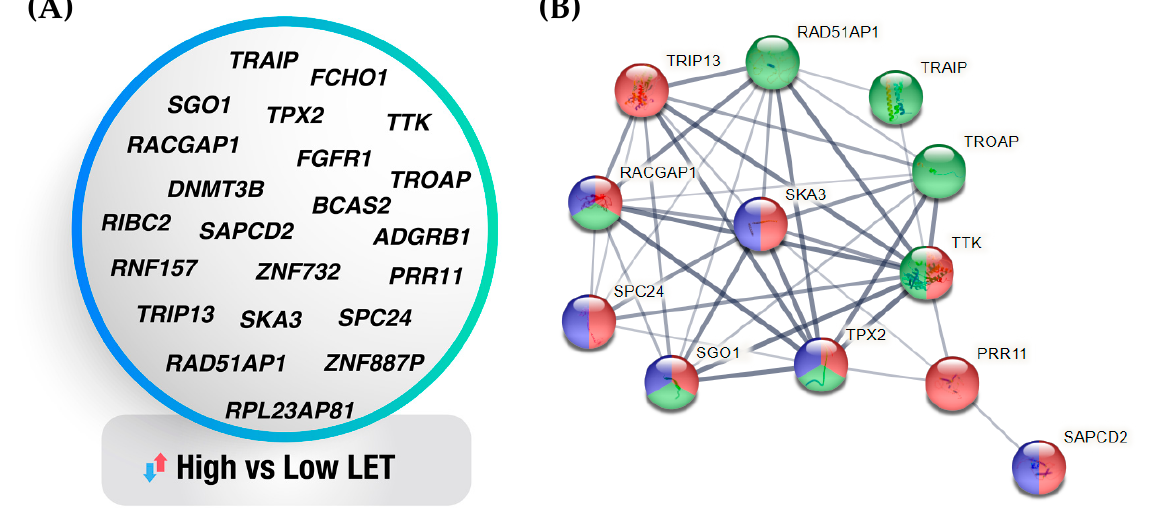
Figure 4. Gene signature of high- versus low-LET radiation types. ( A ) Twenty-two-gene signature characteristic of response to high-LET vs. low-LET irradiation. ( B ) Network depicting the associations (edges) of twelve signature genes/gene products (nodes) in cell cycle (red), cell division (blue) and inflammation (green).